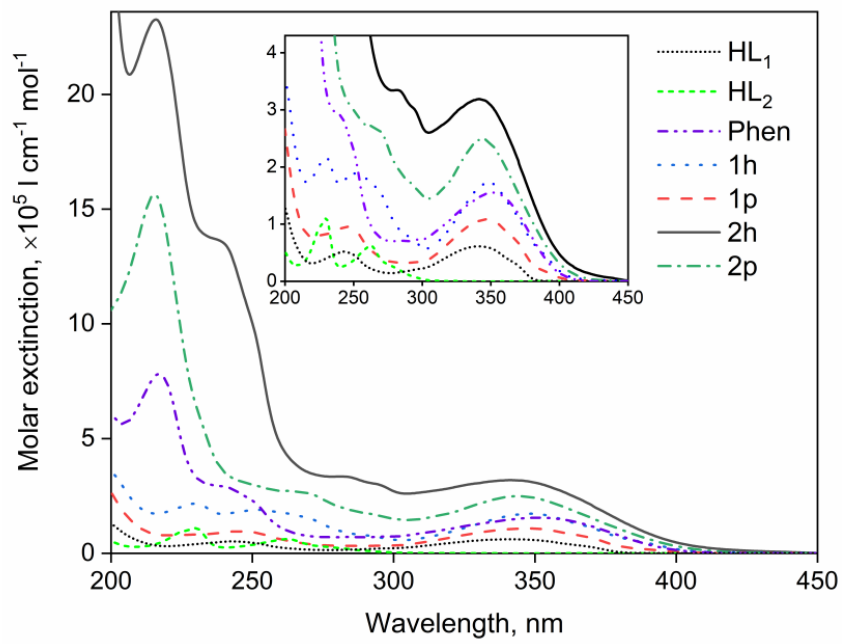
Figure 3. Optical absorption spectra for the complexes studied and free ligands HL 1 , HL 2 and phen in MeCN at room temperature.